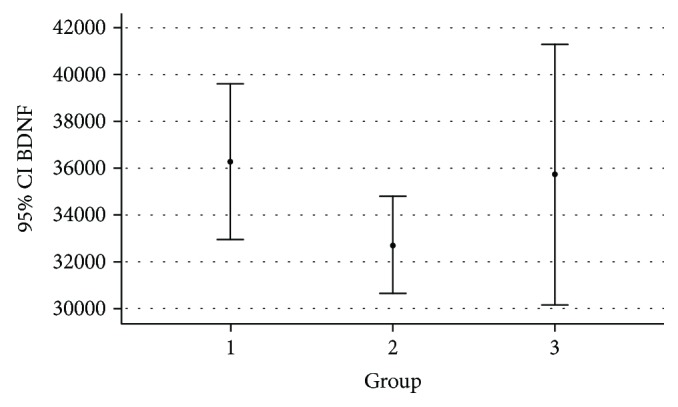
BDNF mean values (pg/ml) and 95% confidence intervals: comparison between groups (1 = SGA, 2 = AGA, 3 = LGA).